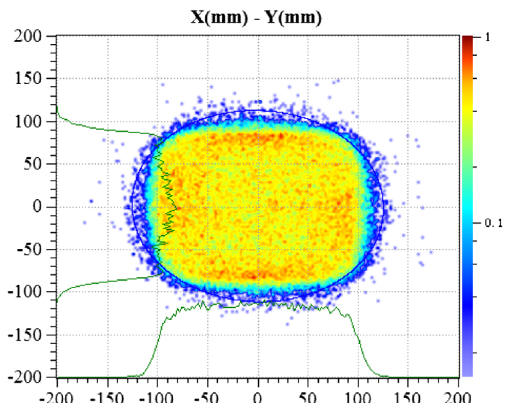
FIG. 28. Expanded and homogenized transverse particle dis- tributions at the 10 MeV beam dump entrance with rf errors and misalignments (counted with 1 × 1 mm cell